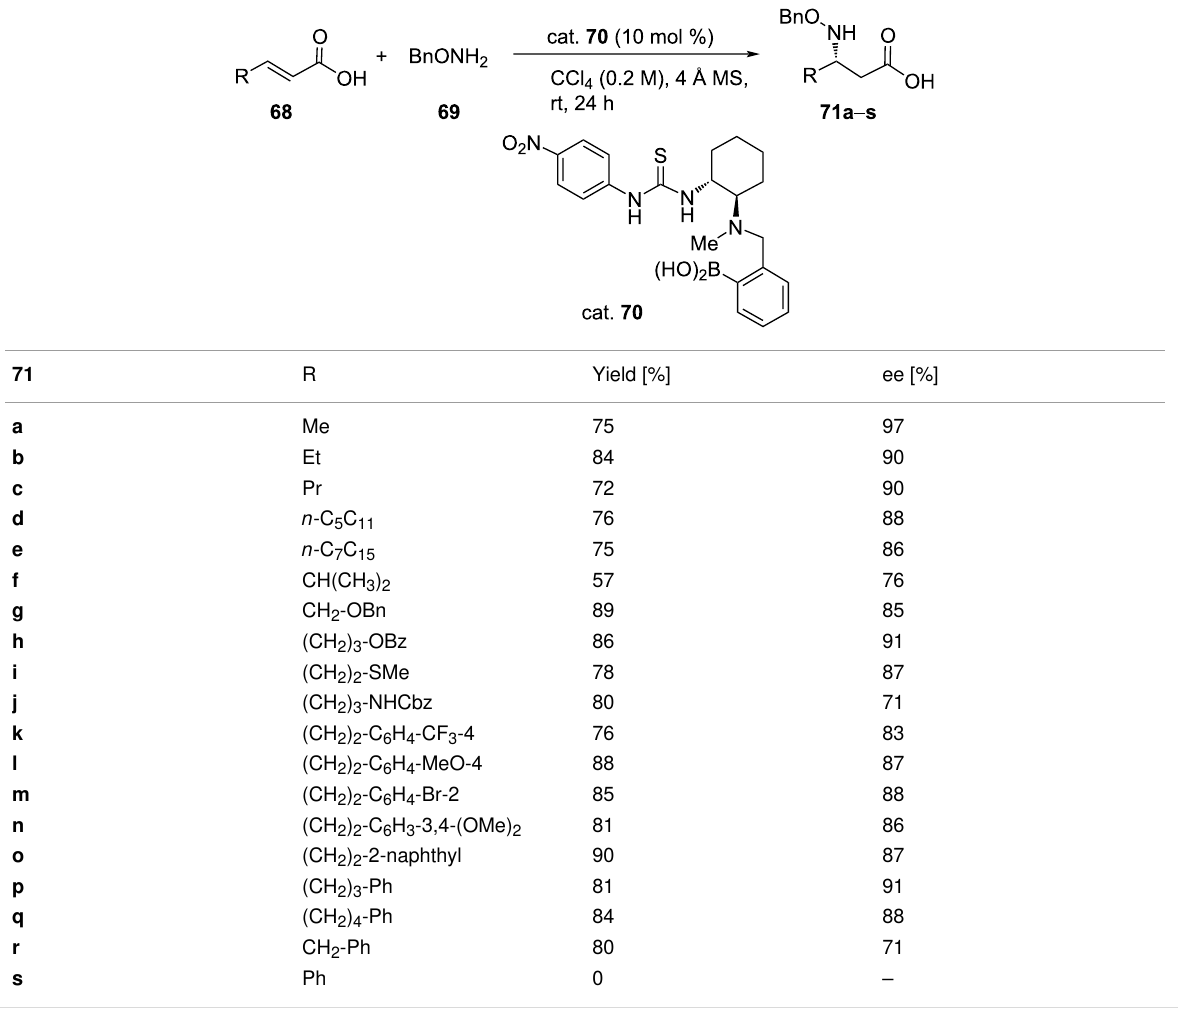
Table 16: Asymmetric intermolecular aza-Michael addition of ( E )-3-substituted-2-enoic acid.